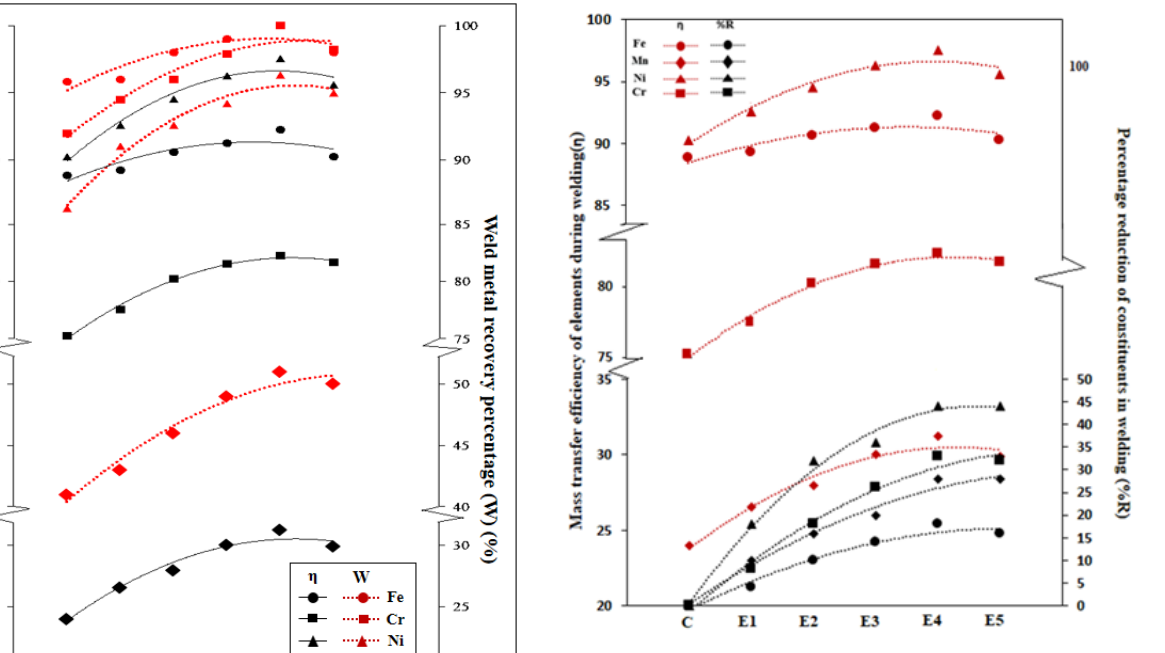
der decrease in η and WMR were observed for E5 due to the excess reactivity offered by nano TiO 2 compared to E4, all the experimental electrodes showed better η and WMR.